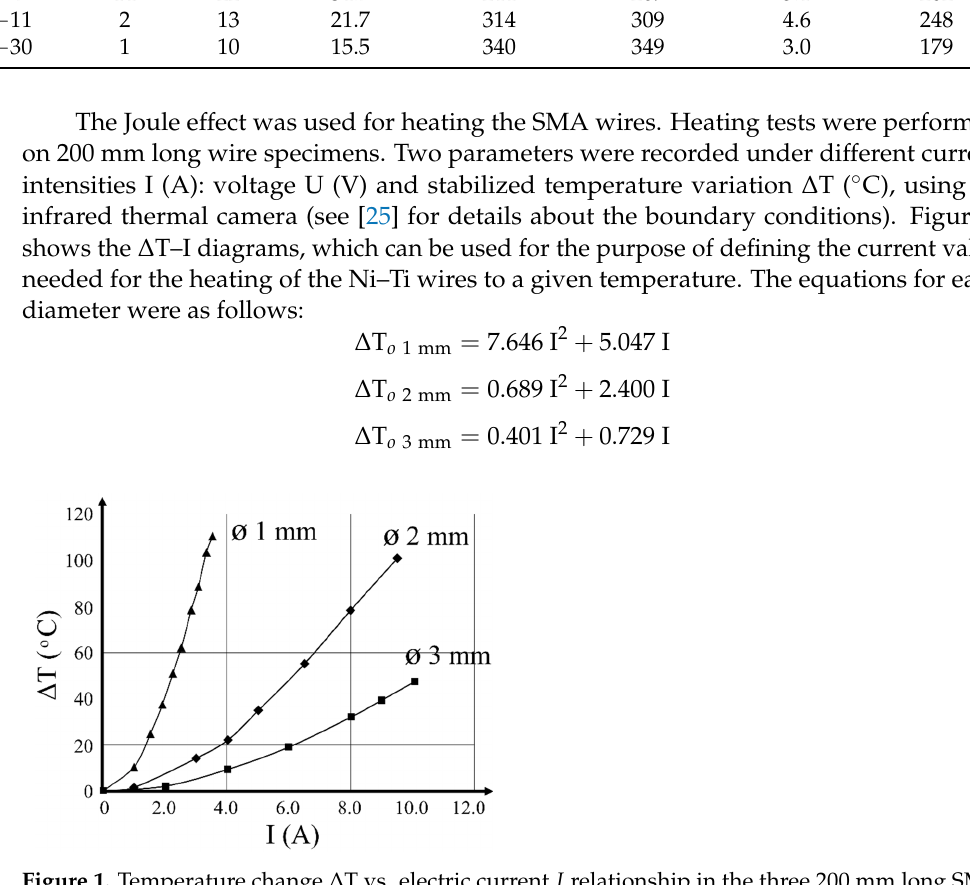
Figure 1. Temperature change ∆T vs. electric current 𝐼 relationship in the three 200 mm long SMA Ni–Ti wires. Ni–Ti